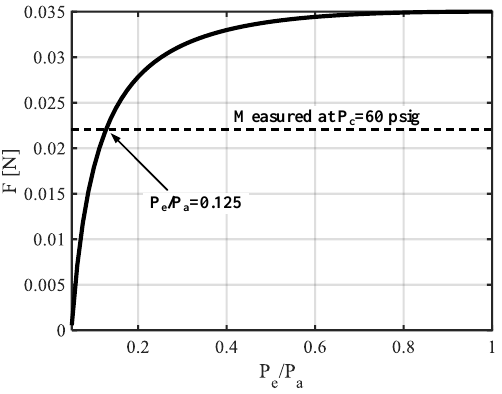
Figure 13. Calculated thrust at different exit pressure ratio values ( P e/ P a) for an inlet pressure of 60 psig and measured thrust.